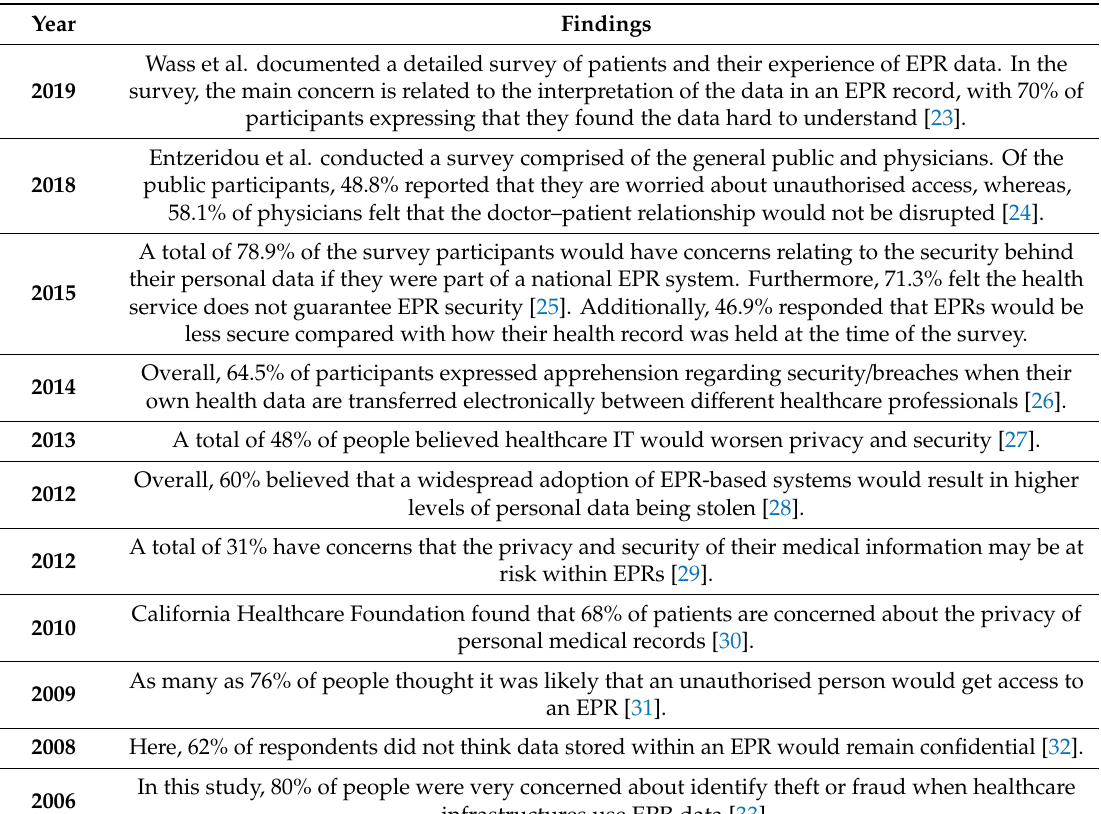
Table 1. Patient privacy concerns by